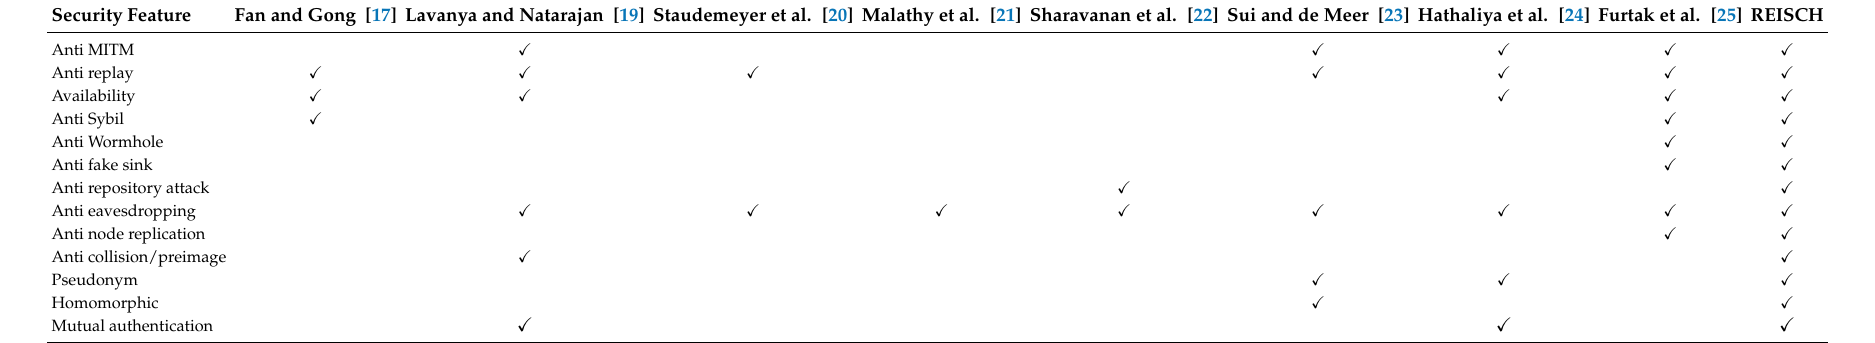
Table 3. Comparison of security